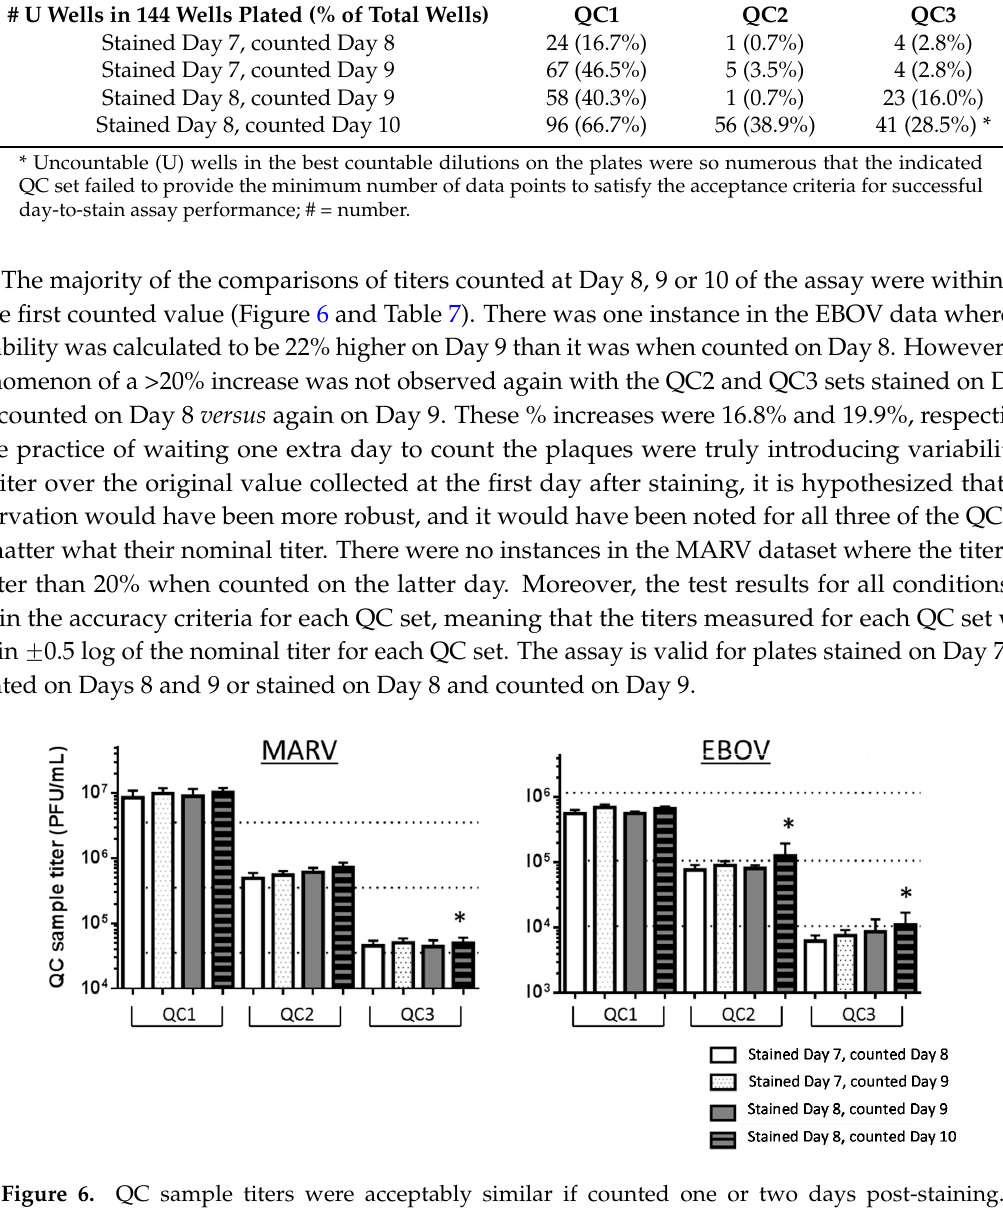
Figure 6. QC sample titers were acceptably similar if counted one or two days post-staining. The averages and standard deviations ( n = 12) for QC1 to 3 titers stained and counted on Days 8, 9 or 10 are presented. The three horizontal dotted lines plot the nominal titers of MARV and EBOV QC1, QC2 and QC3 (Tables 1 and 2). * Indicates a failed dataset, as described in Table 7. Counting on one and two days following staining is an acceptable practice for the validated plaque assay.